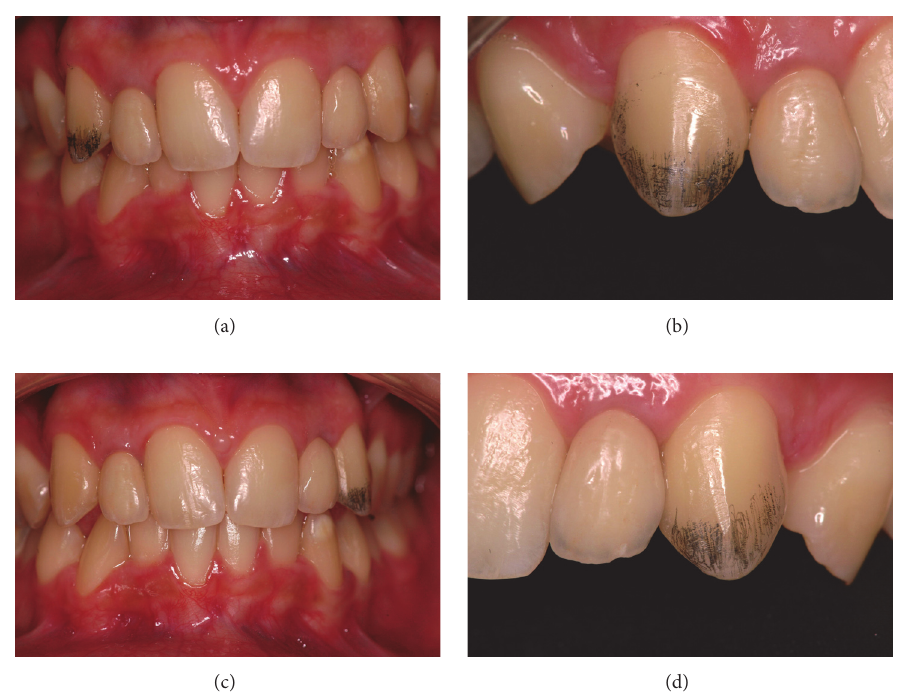
Figure 4: Different view of the guide of selective enamel recontouring of canine maxillary. (a) Marking on the most prominent third of the buccal face of tooth #13. (b) An approximate view of the teeth after enamel recontouring. (c) Marking on the most prominent third of the buccal face of tooth #23. (d) An approximate view of the teeth after enamel recontouring. Note on the proximal saliencies, greater wear was performed in the cervical direction in order to prevent them from remaining more projected and therefore outstanding in the smile.